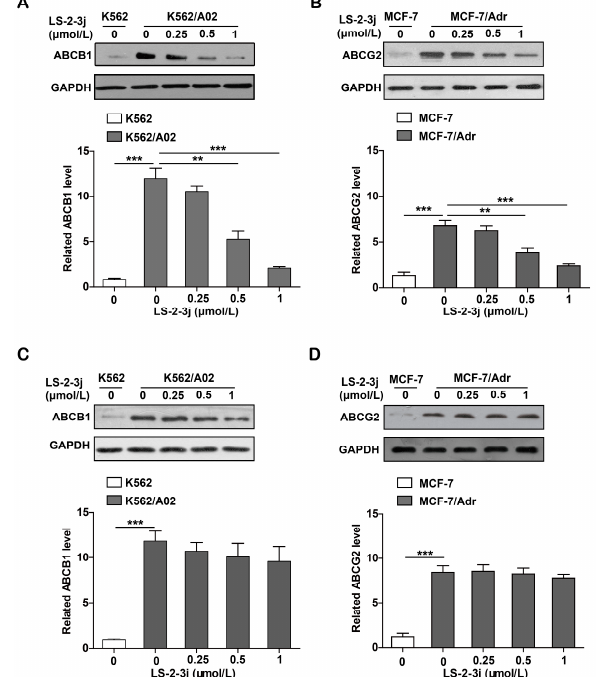
Figure 6. Effect of LS-2-3j on the expression levels of ABCB1 or ABCG2 proteins in K562, K562/A02, MCF-7, and MCF-7/Adr cells. ( A , B ) Effect of LS-2-3j on the expression levels of ABCB1 or ABCG2 proteins at 48 h. ( C , D ) Effect of LS-2-3j on the expression levels of ABCB1 or ABCG2 proteins at 24 h. The protein levels of ABCB1 and ABCG2 in cells after 0, 0.25, 0.5, and 1 μ mol/L LS-2-3j stimulation